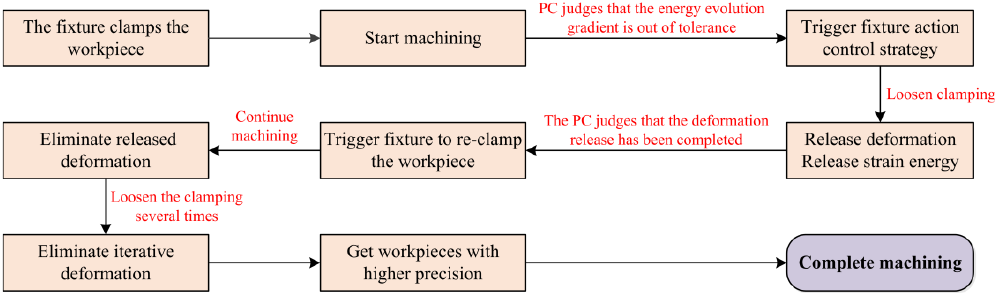
Figure 2. Control flow of floating clamping machining.